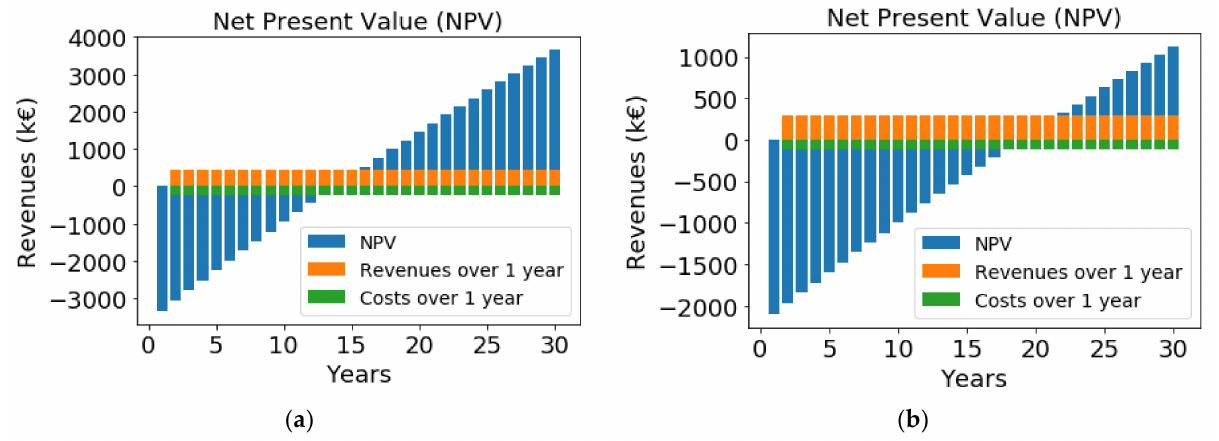
Figure 10. ( a ) r heat = 0.07 € /kWh; ( b ) r heat = 0.05 € /kWh.